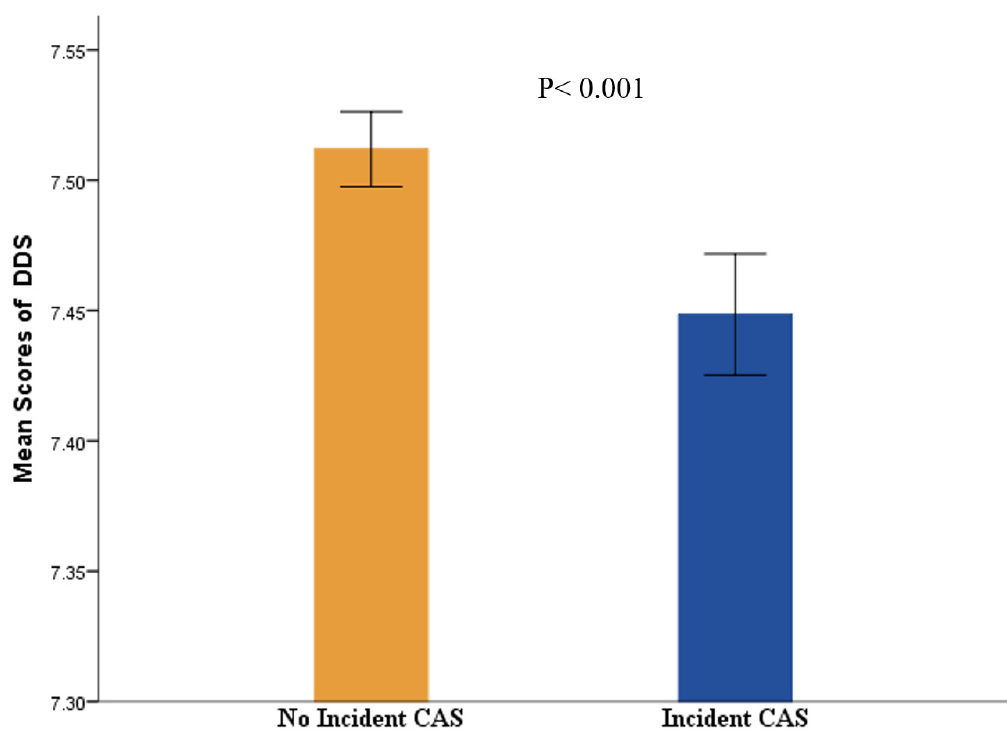
Figure 2. The difference of mean scores of DDS in no incident or incidence of CAS. Abbreviations: CAS, Carotid Atherosclerosis; DDS, dietary diversity scale.